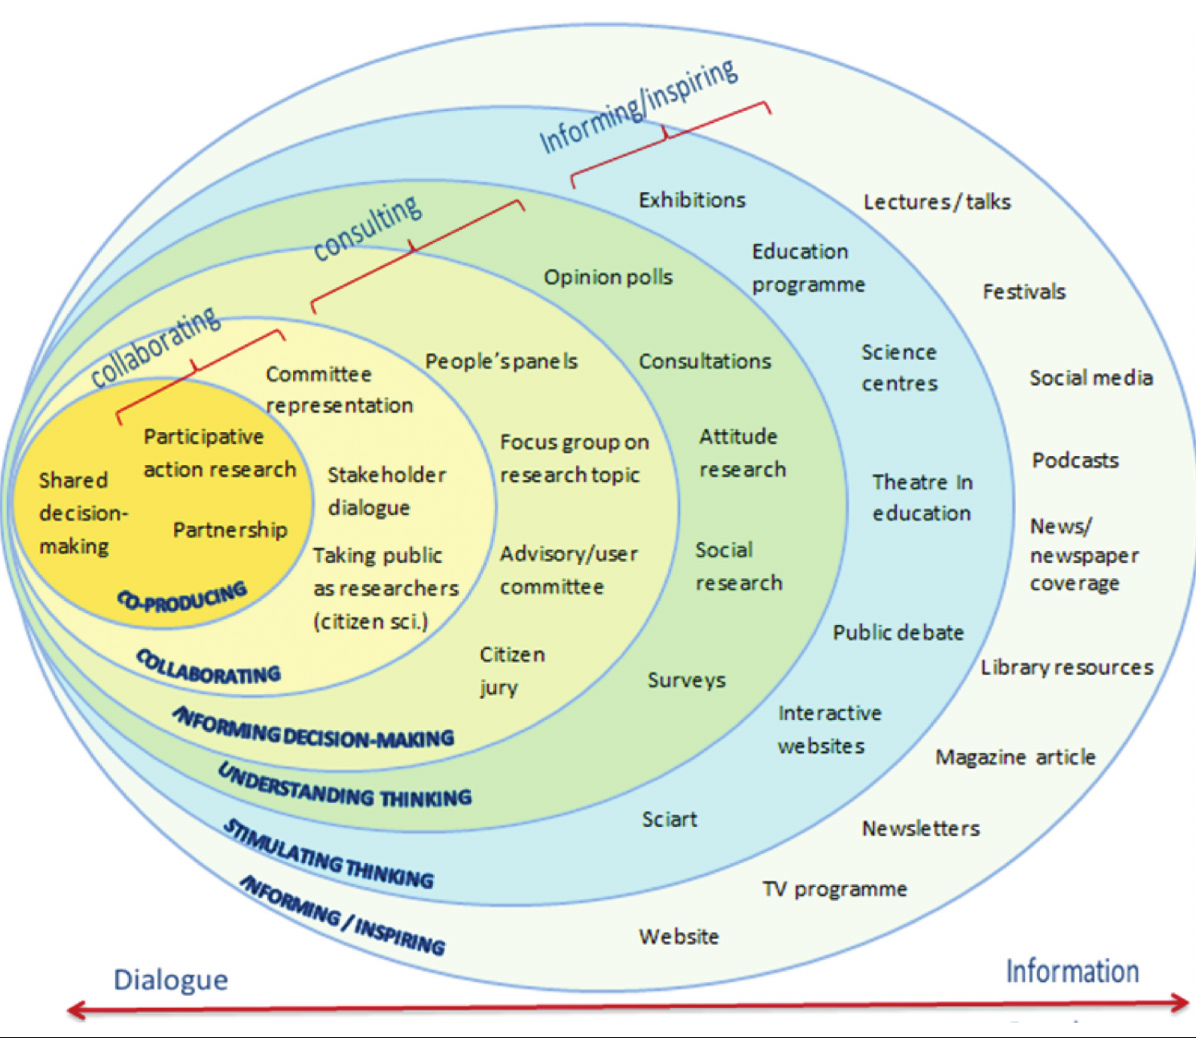
Figure 3. A typology of engagement activities, categorised by ‘order’ (Source: NCCPE/Wellcome